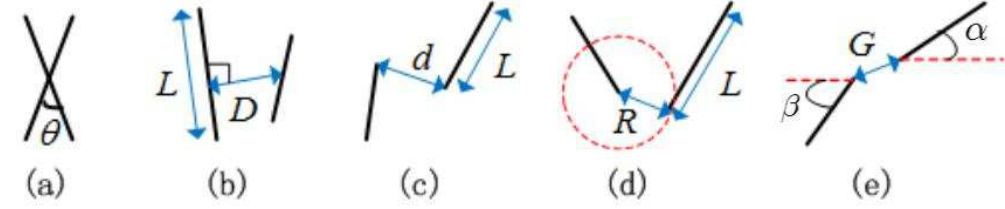
Figure 4. Relational constraints. ( a ) Angular distance; ( b ) lateral distance; ( c ) endpoint distance; ( d ) proximity; and ( e )